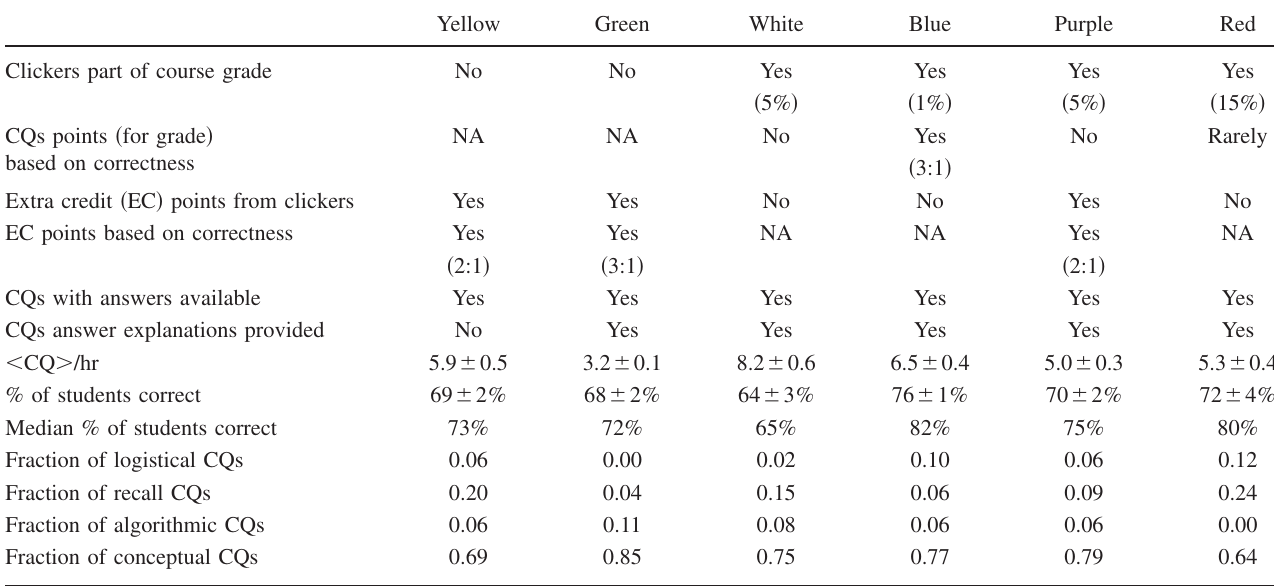
Yellow Green White Blue Purple Red